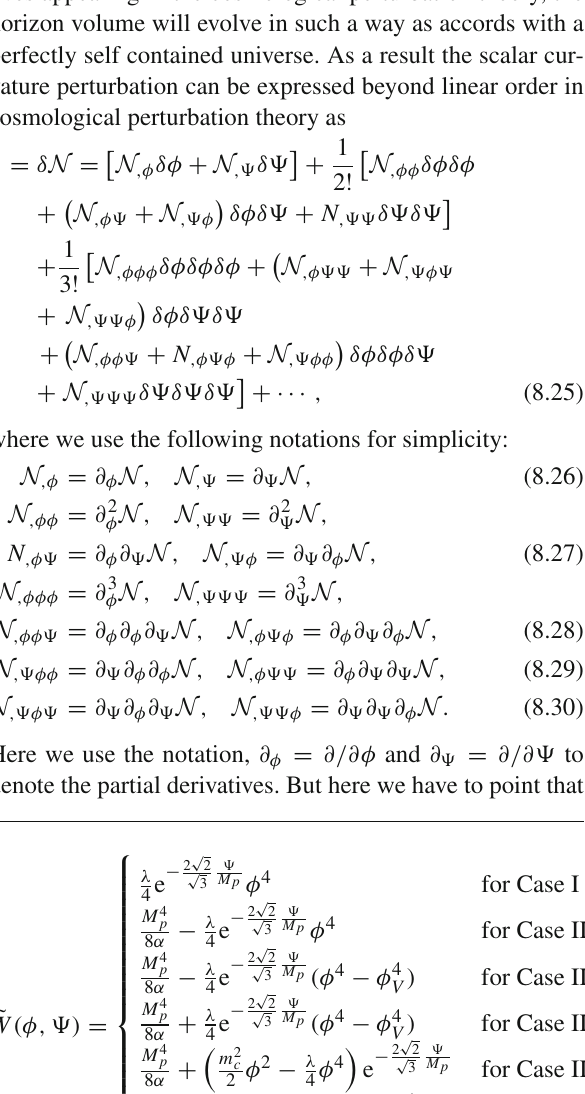
Ini(cid:2)al flat hypersurface